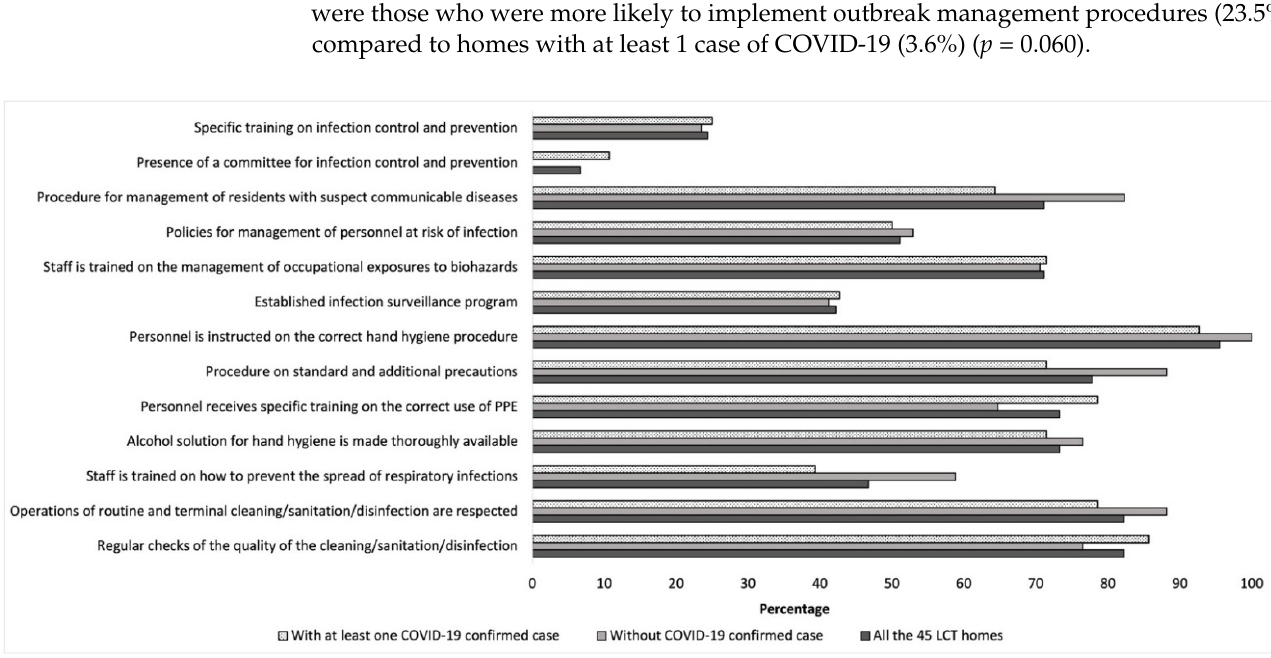
Figure 2. Percentage of LTC homes implementing infection control measures by presence of at least one COVID-19 confirmed case.